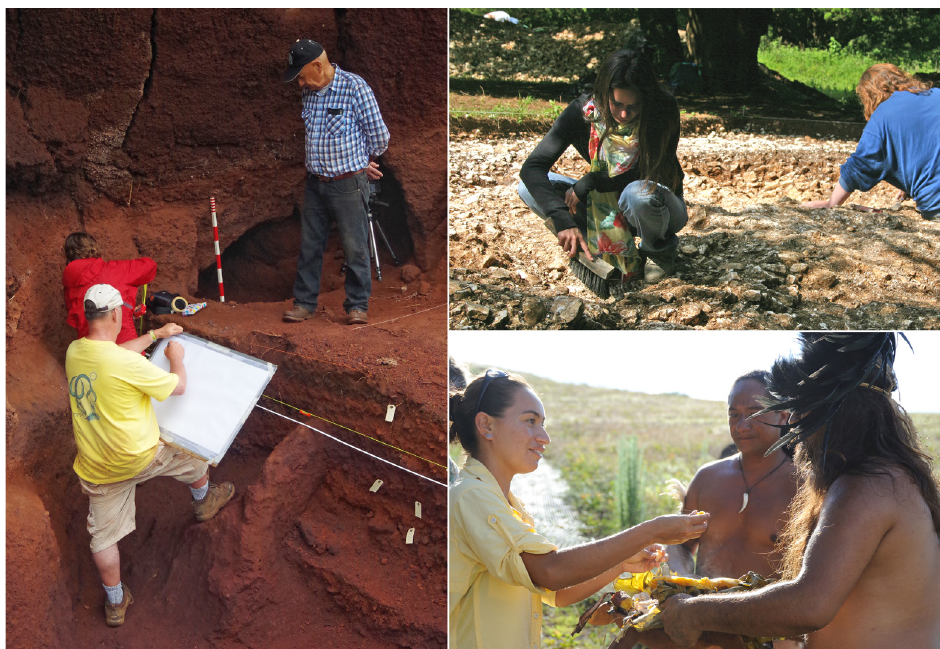
Fig. 3: Rapa Nui colleagues. Clockwise from left: Sorobael Fati overlooking the 2013 excava- tions in the interior of Puna Pau (Colin Richards and Jane Downes are planning the deeply stratified quarry tip lines); Francisca Pakomio on the UCL Institute of Archaeology training excavation at West Dean, West Sussex; and Susana Nahoe, Archaeologist for CONAF Rapa Nui participating in our umu ceremony at the end of a Puna Pau excavation season (photos: M. Seager